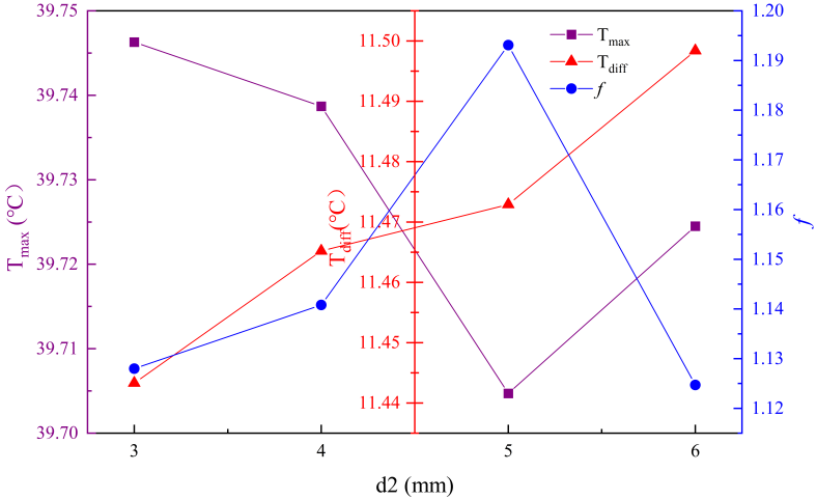
Figure 17. Influence of d 2 on evaluation indexes.